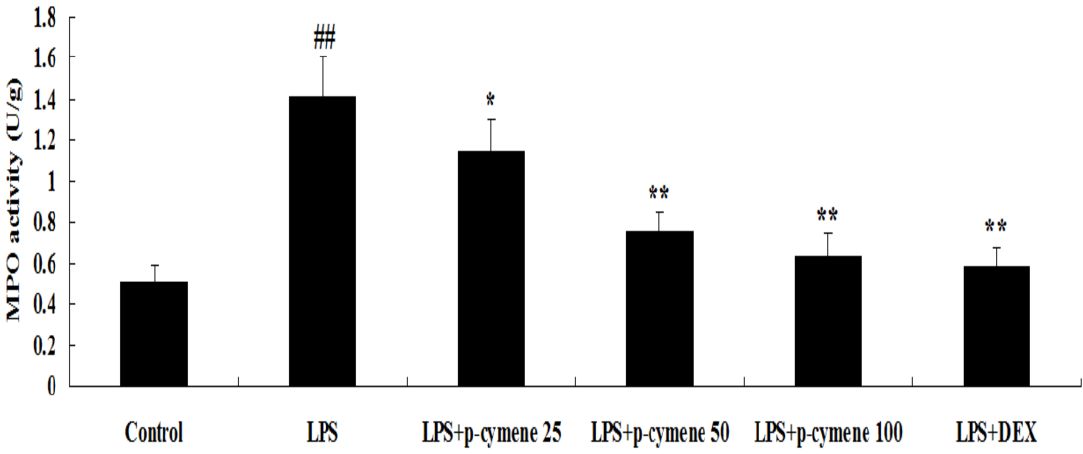
Figure 5. Effects of p -cymene on MPO activity in lungs of LPS-instilled mice. Seven hours after LPS instillation, lung homogenates were prepared for determination of MPO activity. Data are presented as the mean ± SEM (n = 6 in each group). ## p < 0.01 vs. control group, * p < 0.05, ** p < 0.01 vs. LPS